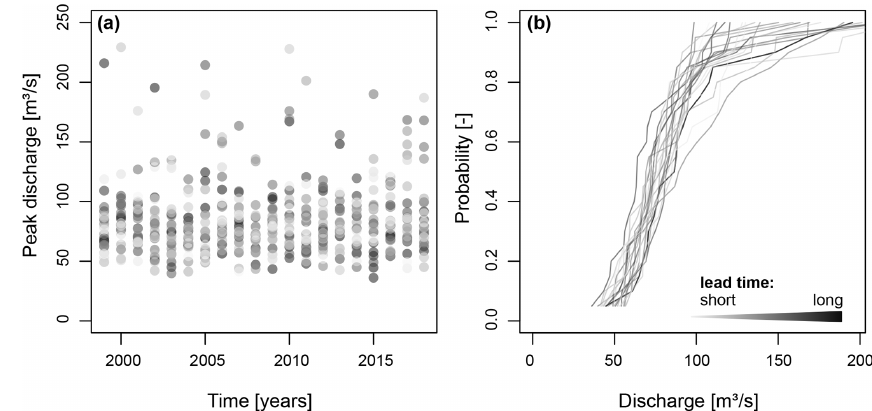
Figure 4. Stability across lead times from 0 to 46d for one example catchment. (a) AM flood events extracted from streamflow time series simulated for 24 lead times (one dot per lead time). (b) Cumulative distribution functions of AM flood samples per lead time (one line per lead time). The darker the colour, the longer the lead time.